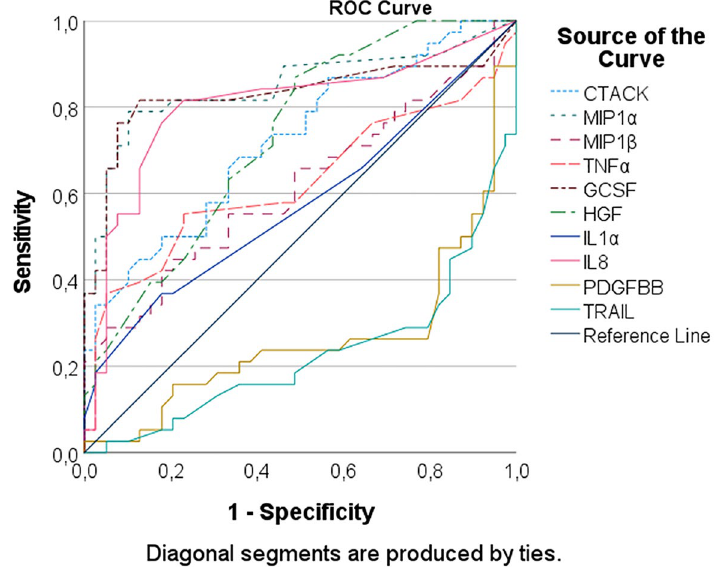
Figure 1. ROC curve of clustering analysis of cytokines contributing in diagnosis of MD.